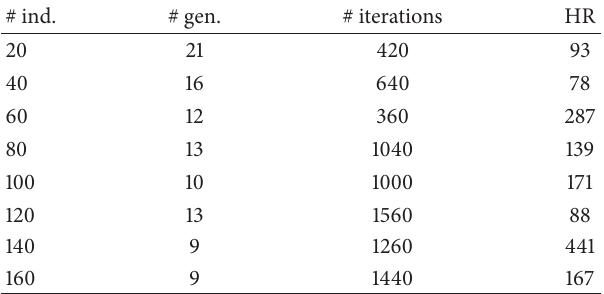
Table 4: This overview shows that, in general, the more the individuals, the smaller the number of generations needed until convergence but the higher the number of total